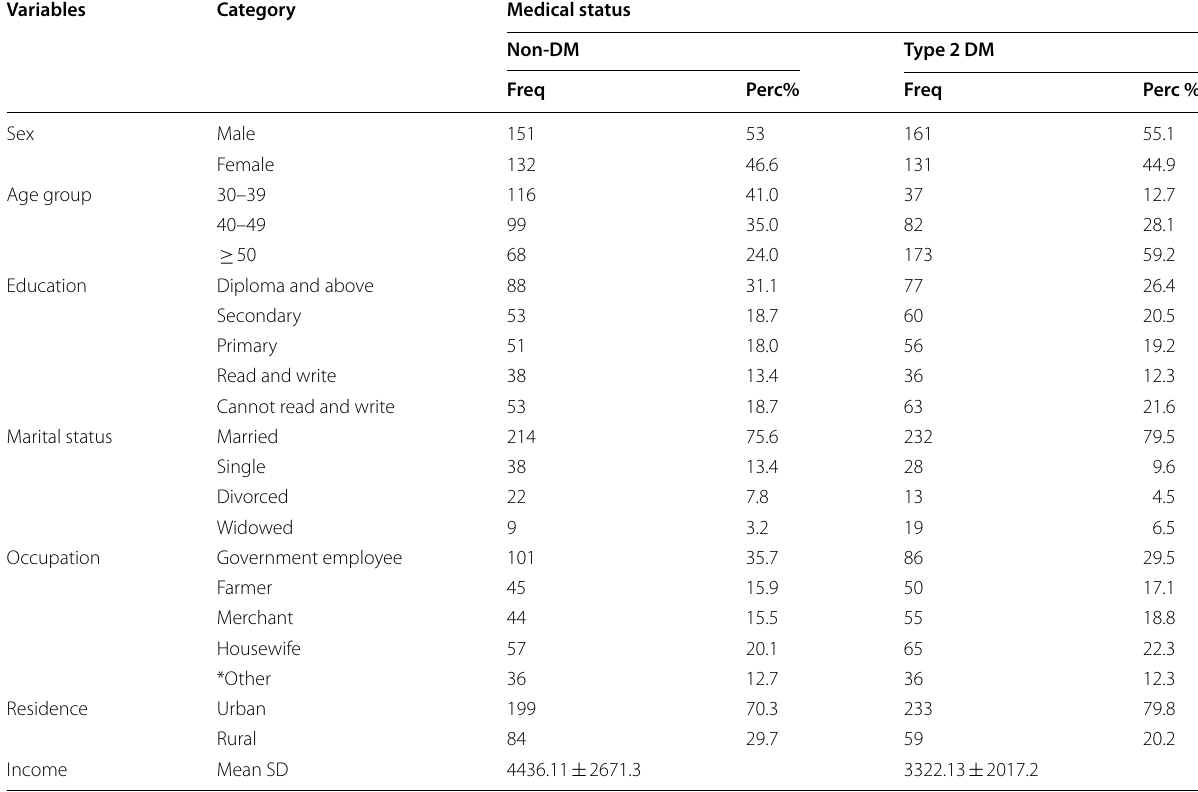
Table 2 Socio-demographic characteristics of individuals with type 2 DM and non- DM individuals in Bahir dar city, Ethiopia, 2021